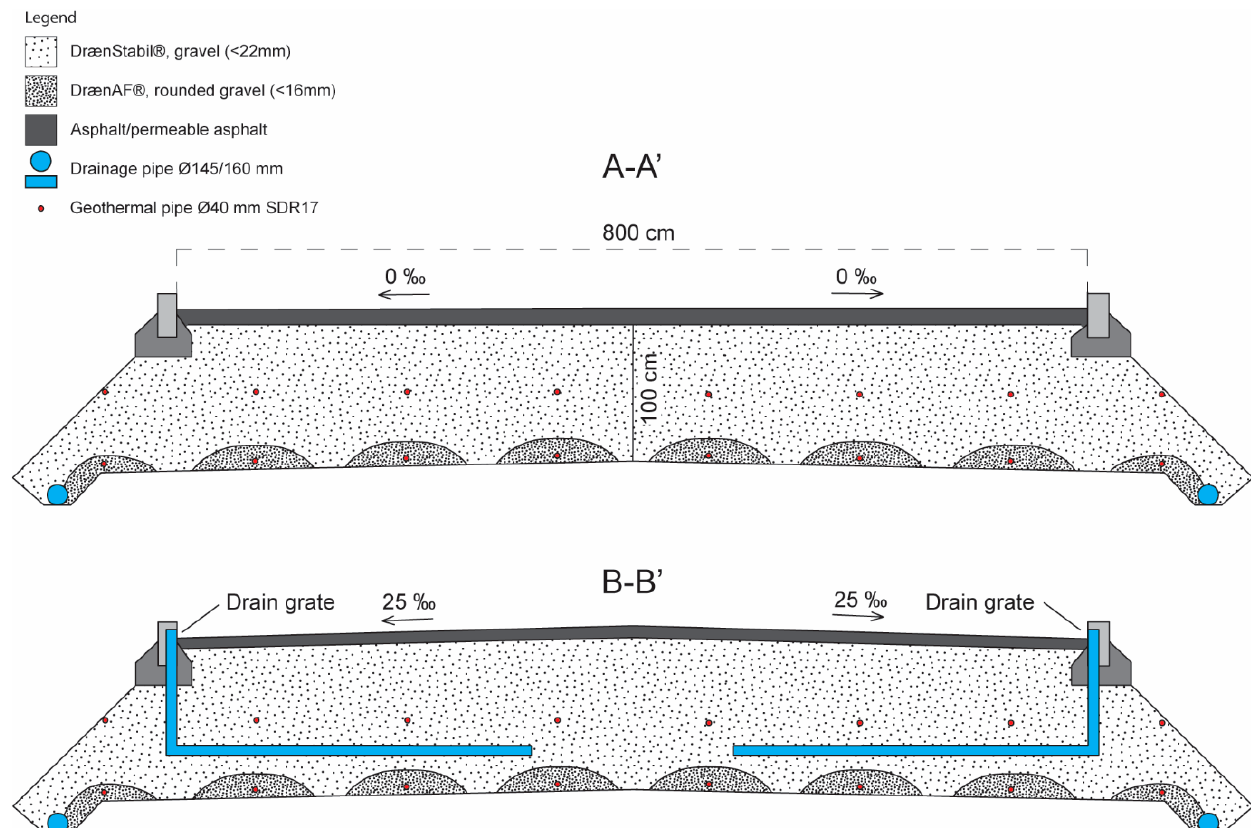
Figure 3. Transect of the road sections with permeable (A-A’) and traditional asphalt (B-B’), respec- tively. A-A’ and B-B’ refer to the transects shown in Figure 1. The permille and arrow labels refer to the inclination of the road surface and its direction. The illustration is not to scale.